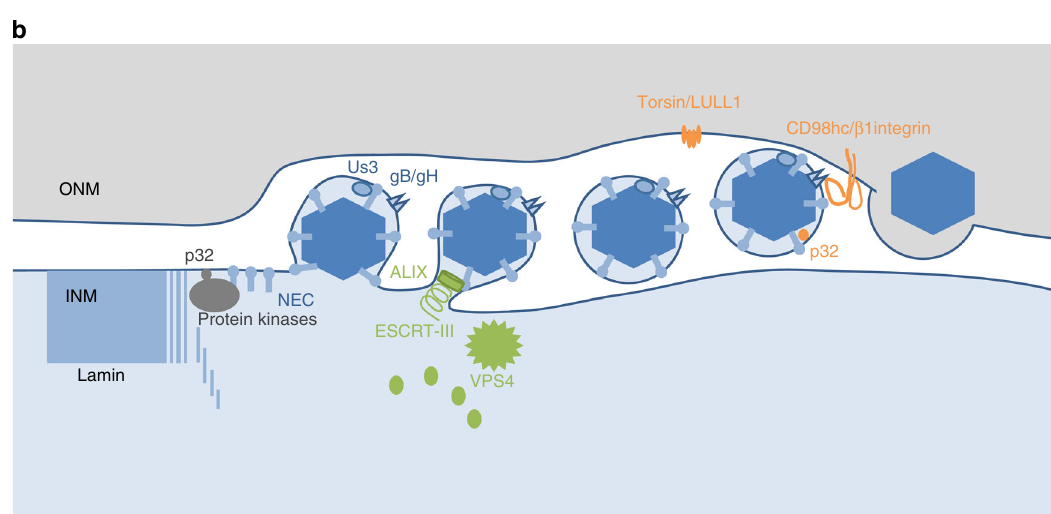
Complete list of primers used in this study is available in the Supplementary Table 2.